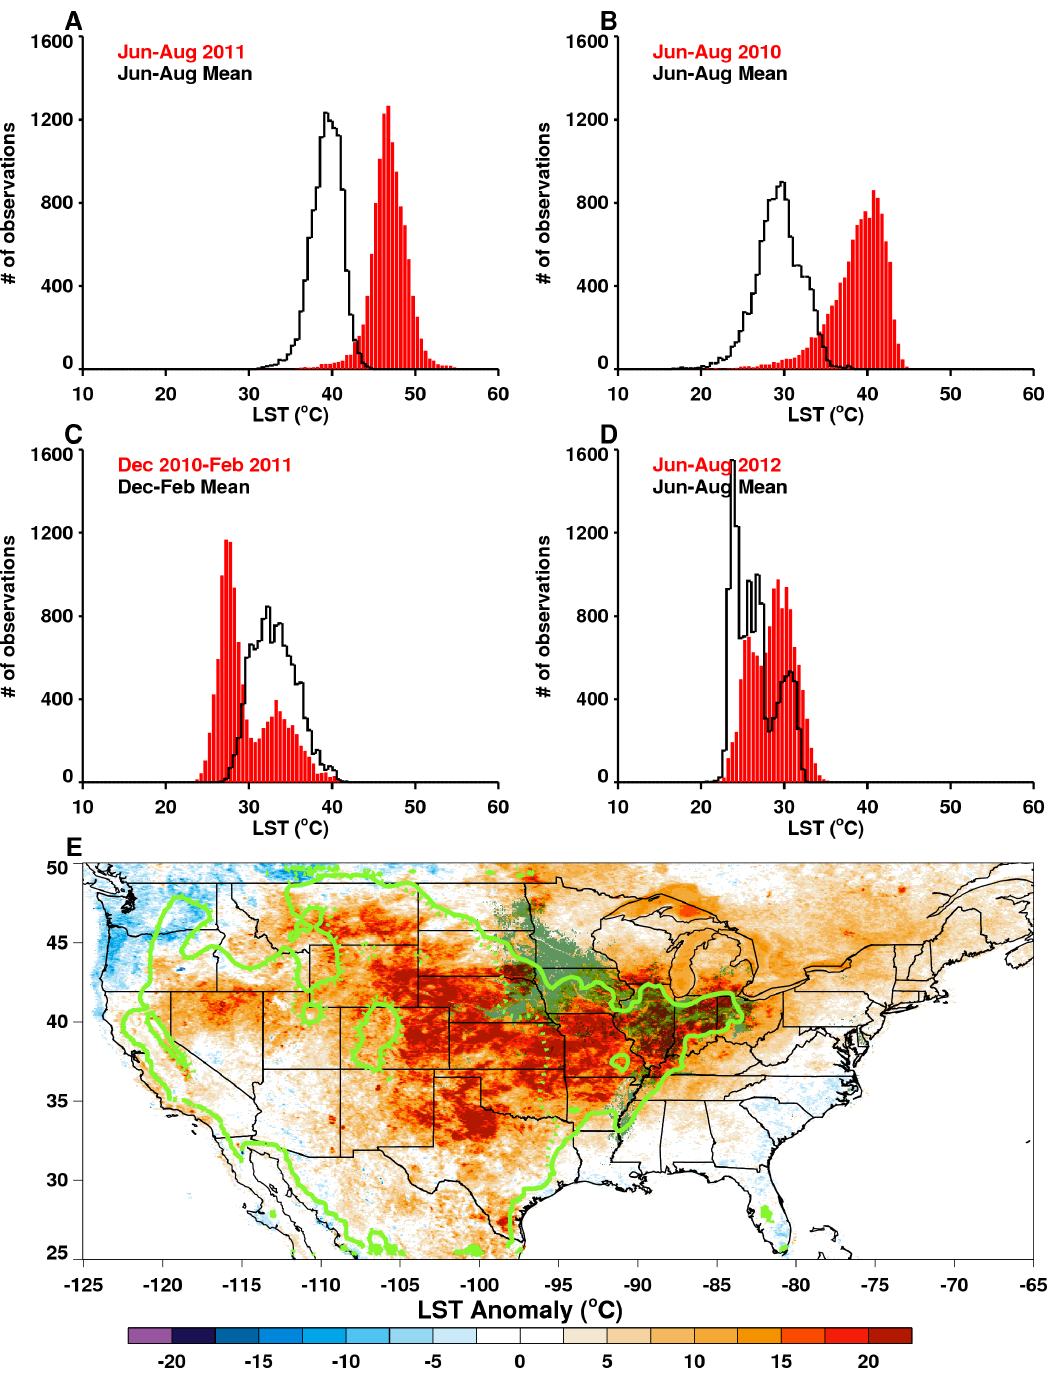
Figure 4. (A–D) Histograms of MODIS growing season land surface temperature (LST) distributions (red bars) compared against the long-term means (black lines) for selected regions of study. (E) Spatial pattern of LST anomalies for the US during June, July, August (JJA) 2012. The area shaded in olive green shows the dominant corn and soy growing region; the solid neon green line delineates the JJA 2012 seasonal 30 u C isocline which encompasses the majority of the US agricultural region; and the dotted neon green line shows the JJA 2000–2011 long-term mean 30 u C isocline. Persistent temperatures above 30 u C destroy most crops and reduce yields [6,17,57].